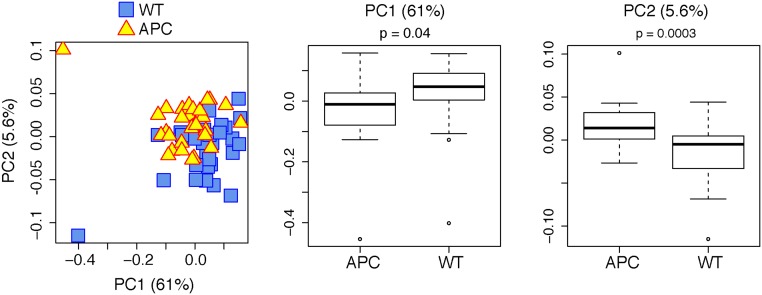
Principle Coordinate Analysis.PCoA was conducted at the family taxonomic level using a pairwise dissimilarity matrix calculated using the Morisita-Horn beta-diversity index. Each triangle is representative of a single APCMin/+ (APC) mouse and each square is representative of a single WT mouse, plotted along the first two principal component axes (left panel). PC1 and PC2 accounted for 61% and 5.6%, respectively, of total variance. The middle and right panels display the PC scores along axes 1 and 2, respectively. Differences in scores between genotypes were assessed by student t-test.